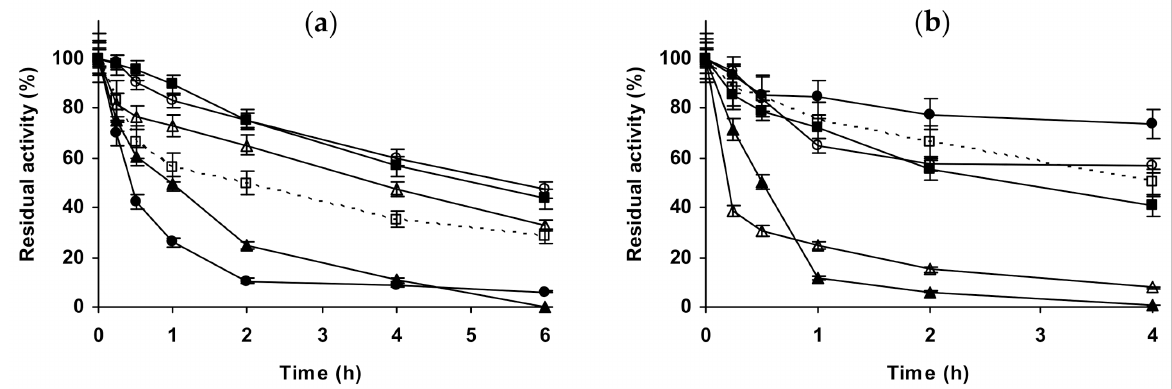
Figure 9. Effect of ionic strength and inactivation pH on the stability of glutaraldehyde- β -galactosidase. ( a ) pH 5.0 and 58 ◦ C; ( b ) pH 7.0 and 58 ◦ C. Other specifications are described in the Methods section. Dotted line, empty squares: references; full triangles: 1 M NaCl; empty triangles: 3 M NaCl; full circles: 1 M (NH 4 ) 2 SO 4 ; empty circles: 3 M (NH 4 ) 2 SO 4 and full squares: 1 M Na 2 SO 4